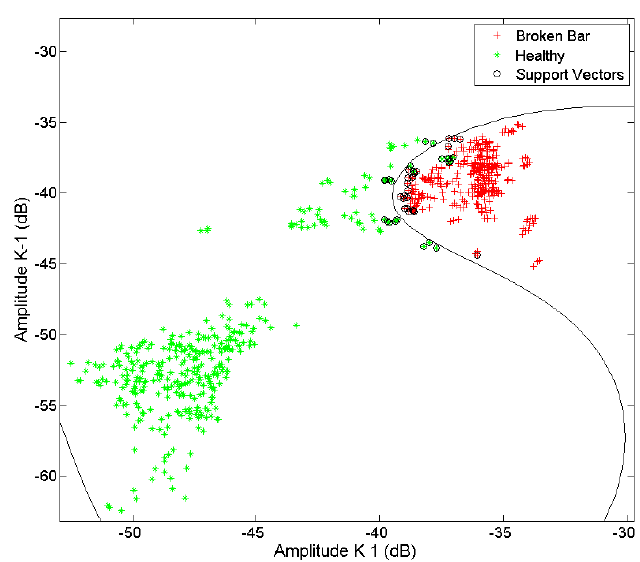
Figure 3. Space of a 2-dimensional SVM (2 parameters on each failure representative feature) where a hyperplane is splitting the space in subspaces of healthy features and failure features.